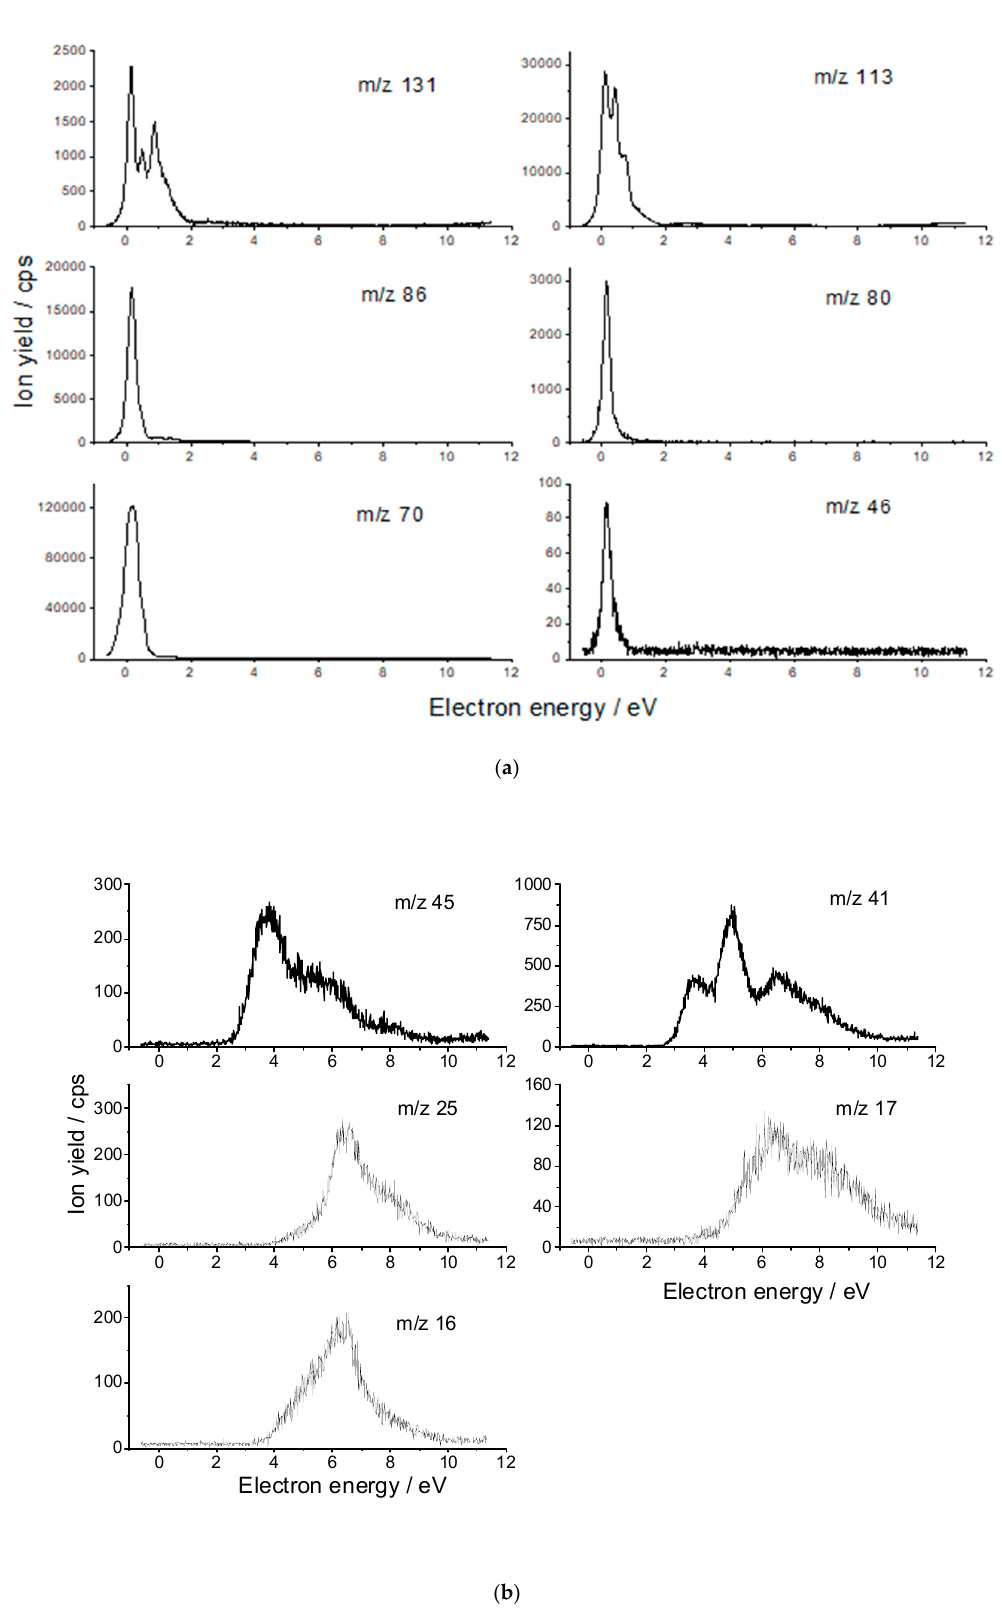
Figure 2. Anion yield functions of the oxaloacetic acid ( a ) fragment anions with m/z 131, 113, 86, 80, 70 and 46, and ( b ) fragment anions with m/z 45, 41, 25, 17, and